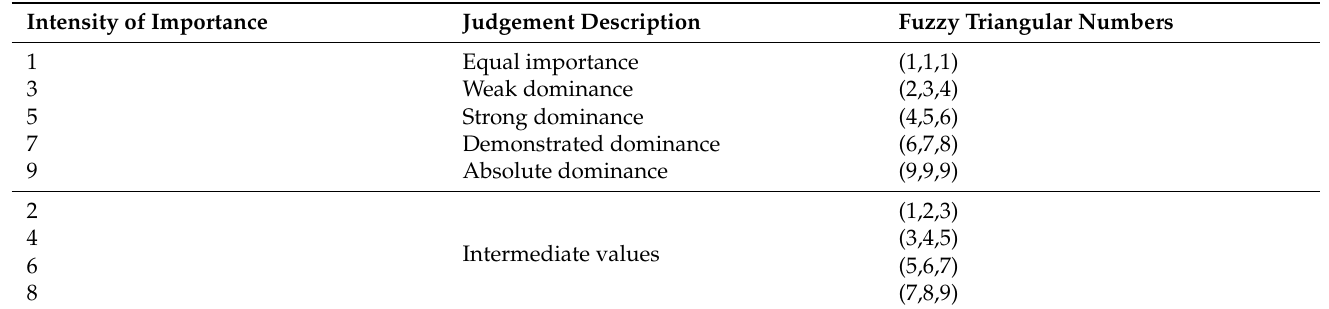
Table A3. AHP-Saaty pairwise comparison scale and the equivalent TFNs